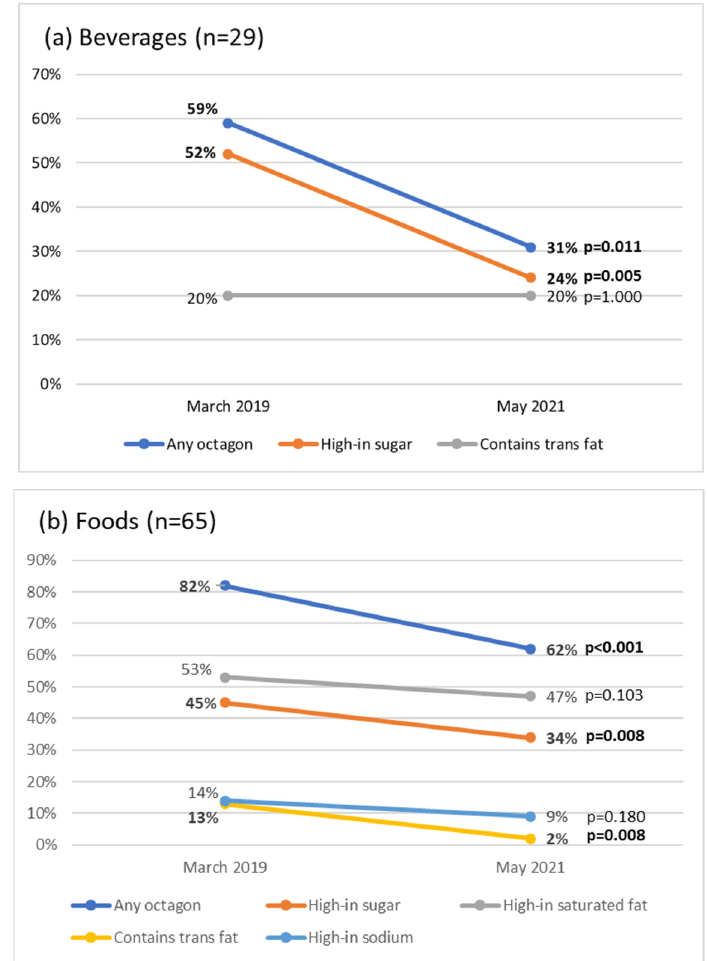
Figure 3. Percentage of products that would carry front-of package warning labels before and after the policy implementation according to the first-phase nutritional thresholds. Comparisons were made using the Cochran test. Bold values represent p < 0.05.